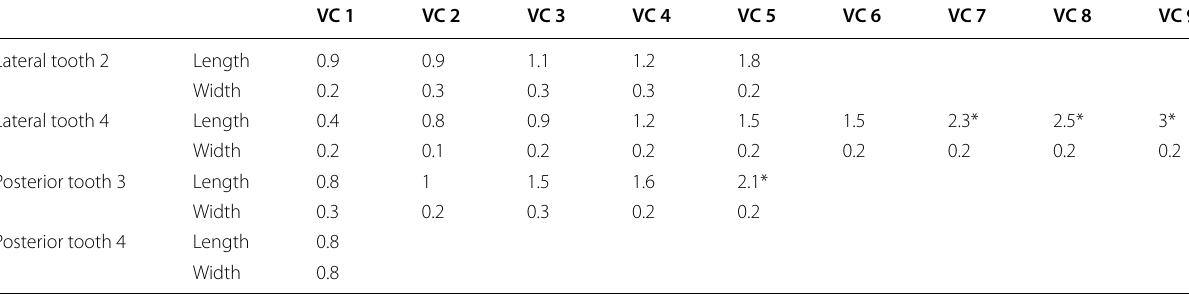
Some of them were curved (marked by an asterisk *); the values are given without following the angles